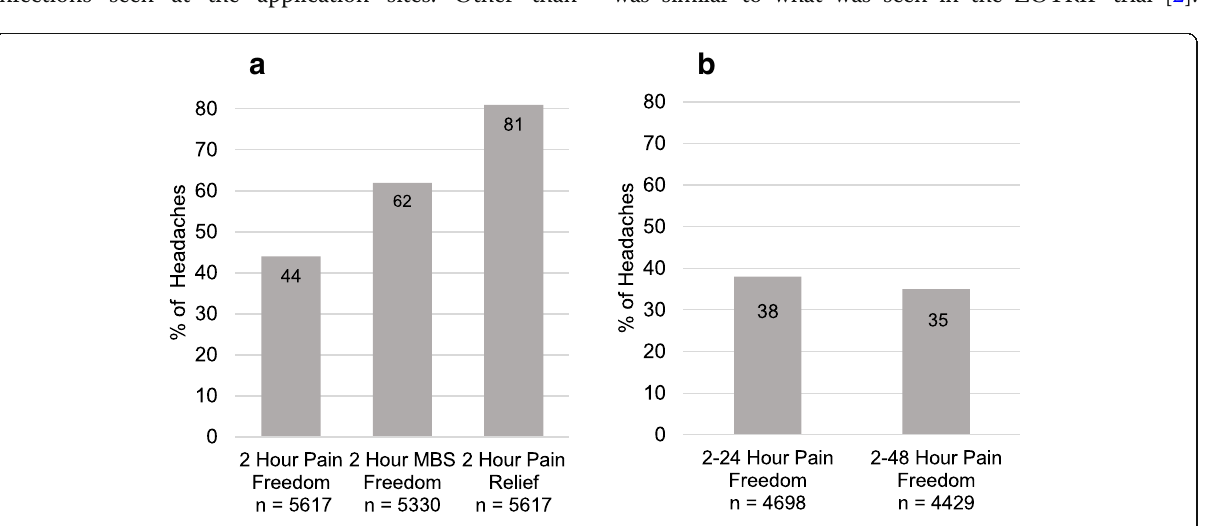
Fig. 2 Key Efficacy Outcomes. a Percentage of headaches for which subjects experienced freedom from headache pain and/or most bothersome other migraine-associated symptom at 2 h post-dose. Results for MBS-freedom are presented only for those whose MBS was present pre-dose. Numbers below bars indicate number of headaches assessed. MBS: Most Bothersome Symptom. b Percentage of headaches for which subjects had sustained pain freedom from 2 to24 hours and from 2 to 48 h post-dose. Numbers below bars indicate number of headaches